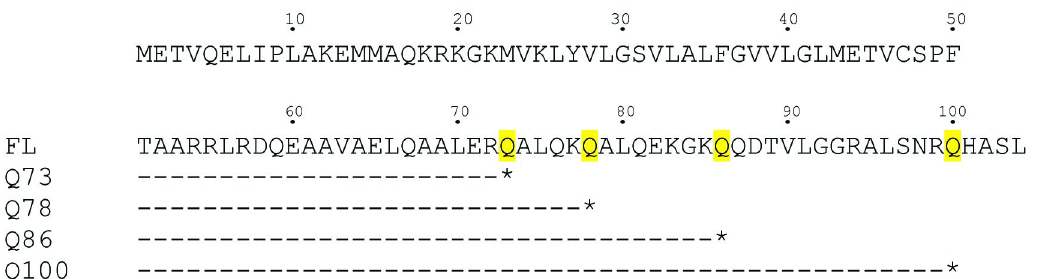
Fig 1. Truncation design of Q73, Q78, Q86, and Q100 compared to the full length (FL) MBP-G0S2. Nucleotides coding for glutamine at residues Q73, Q78, Q86, and Q100 were mutated to an ochre stop codon (shown as � ) for the Q73, Q78, Q86, and Q100 constructs,